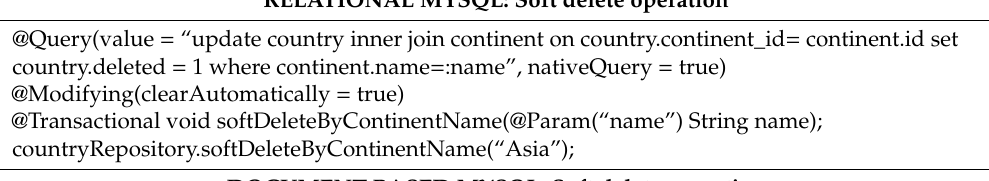
Table 9. Soft delete operations.